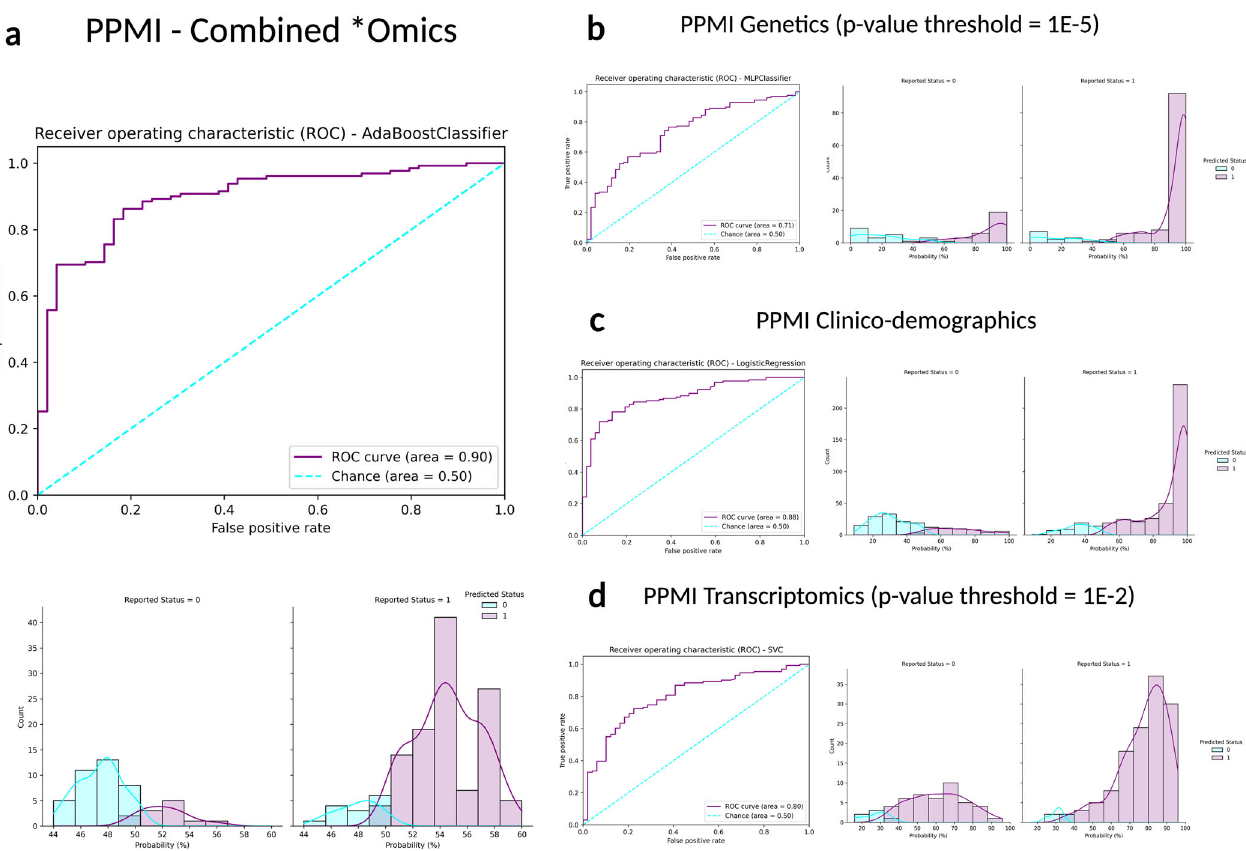
Fig. 2 Receiver operating characteristic curves and case probability density plots in withheld training samples at default thresholds comparing performance metrics in different data modalities from the PPMI dataset. P values mentioned indicate the threshold of signi fi cance used per datatype, except for the inclusion of all clinico-demographic features. a PPMI combined *omics dataset (genetics p value threshold = 1E-5, transcriptomics p value threshold = 1E-2, and clinico-demographic information); b PPMI genetics-only dataset ( p value threshold = 1E-5); c PPMI clinico-demographics only dataset; d PPMI transcriptomics-only dataset ( p value threshold = 1E-2). Note that x-axis limits may vary as some models produce less extreme probability distributions than others inherently based on fi t to the input data and the algorithm used, further detailed images are included in Supplementary Fig. 5. PPMI Parkinson ’ s progression marker initiative, ROC receiver operating characteristic curve. Table 3. Performance metric summaries comparing at tuned cross-validation in withheld samples in